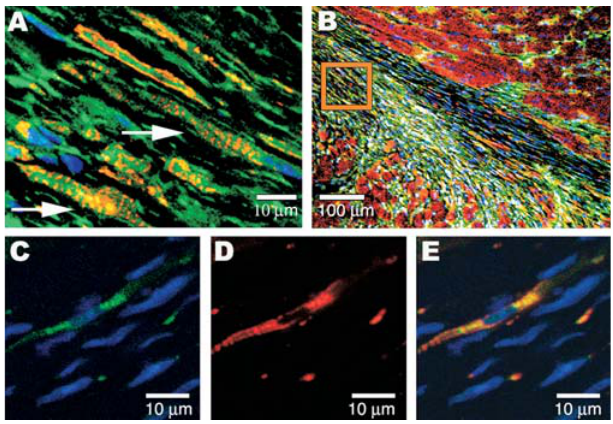
Figure 7. In Vivo Myocardial Infarction Transplantation Studies (A) The GFP-tagged Spoc cells (green), unfractionated for Sca-1, injected into the peripheral blood of a murine acute infarct model have developed after 14 wk into cardiomyocytes (arrows) within the infarct region. Donor Spoc cell–derived GFP cardiomyocytes are characterized by single central nuclei and striations staining for RLCP (red). (B) Longitudinal fresh-frozen tissue slice showing the region of infarct from which (A) was taken (orange box) and adjacent normal endogenous cardiac tissue (RLCP, red). (C) GFP þ /Sca-1 (cid:1) Spoc cells were injected into the peripheral circulation of a murine acute MI model and are detected in the infarct after 4 wk by expression of GFP (green). (D) RLCP (red) is also expressed. (E) Overlay of (C) and